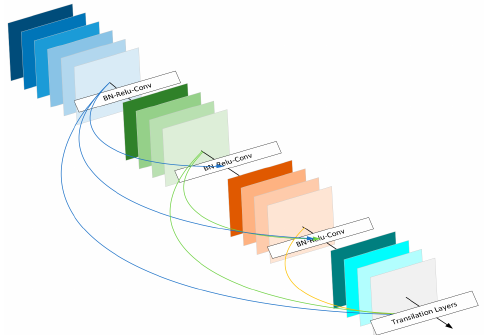
Figure 3. Schematic diagram of the DenseBlock